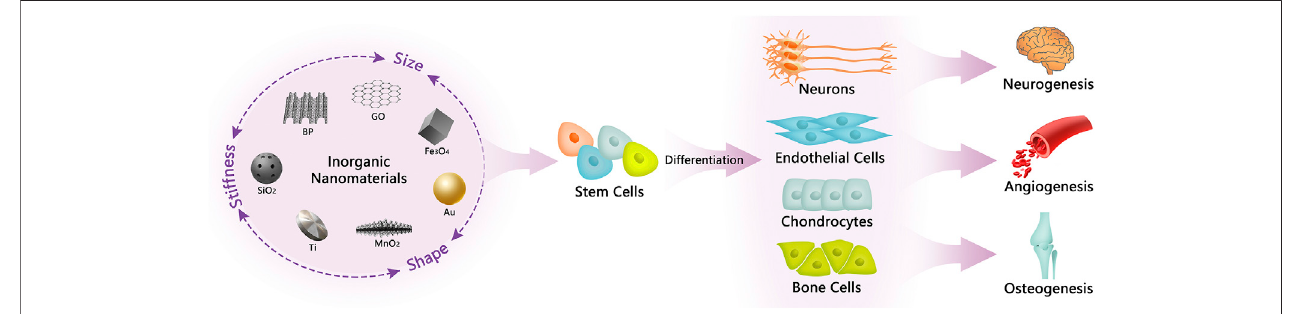
FIGURE 1 | Illustration of inorganic NMs in regulating stem cell differentiation and their biological applications. The physical properties of inorganic NMs, including stiffness, shape, andsize,canin fl uence theguidanceofinorganic NMstothefateofstemcells, whichinturnmediatethedifferentiationofstemcellstoproduce different kinds of functional cells that are bene fi cial for neurogenesis, angiogenesis, and